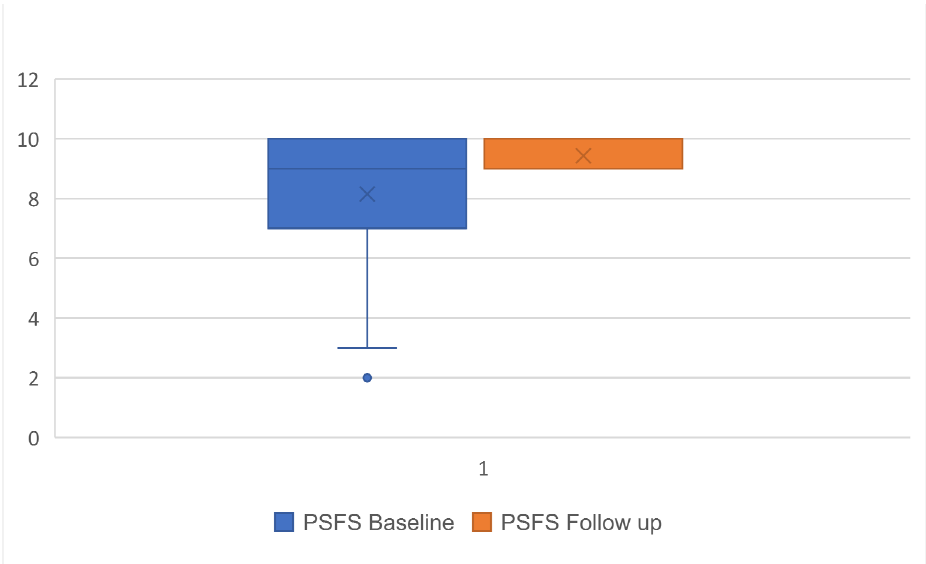
Figure 3. Boxplot of mean and SD for Patient-Specific Functional Scale (PSFS) scores at baseline and follow-up.